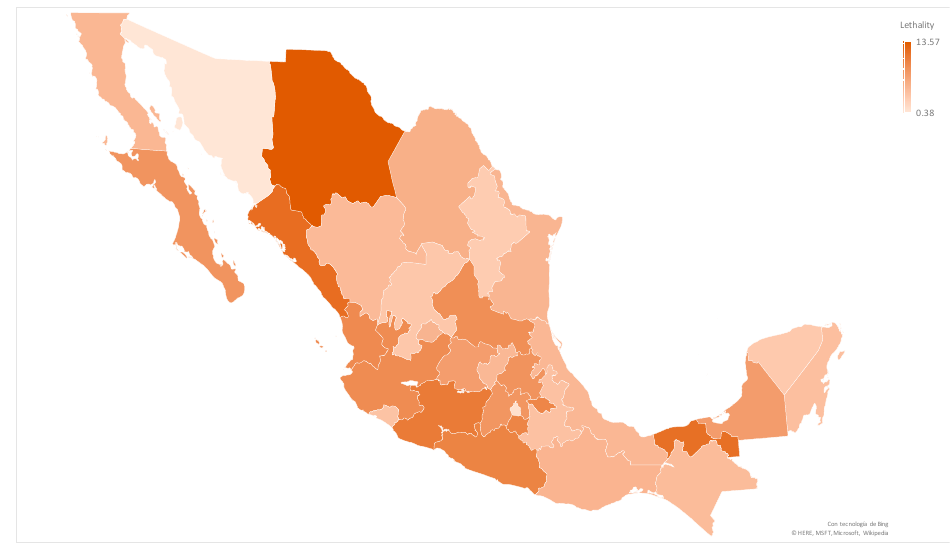
Figure A2. COVID-19 Lethality by state in Mexico through Phase 1 and 2, 2020 ( n = 969 by state-clusters). COVID-19 lethality by state in Mexico, in which the color is adjusted depending on the result of deaths per confirmed cases. The states with the highest lethality were Chihuaha and Sinaloa.